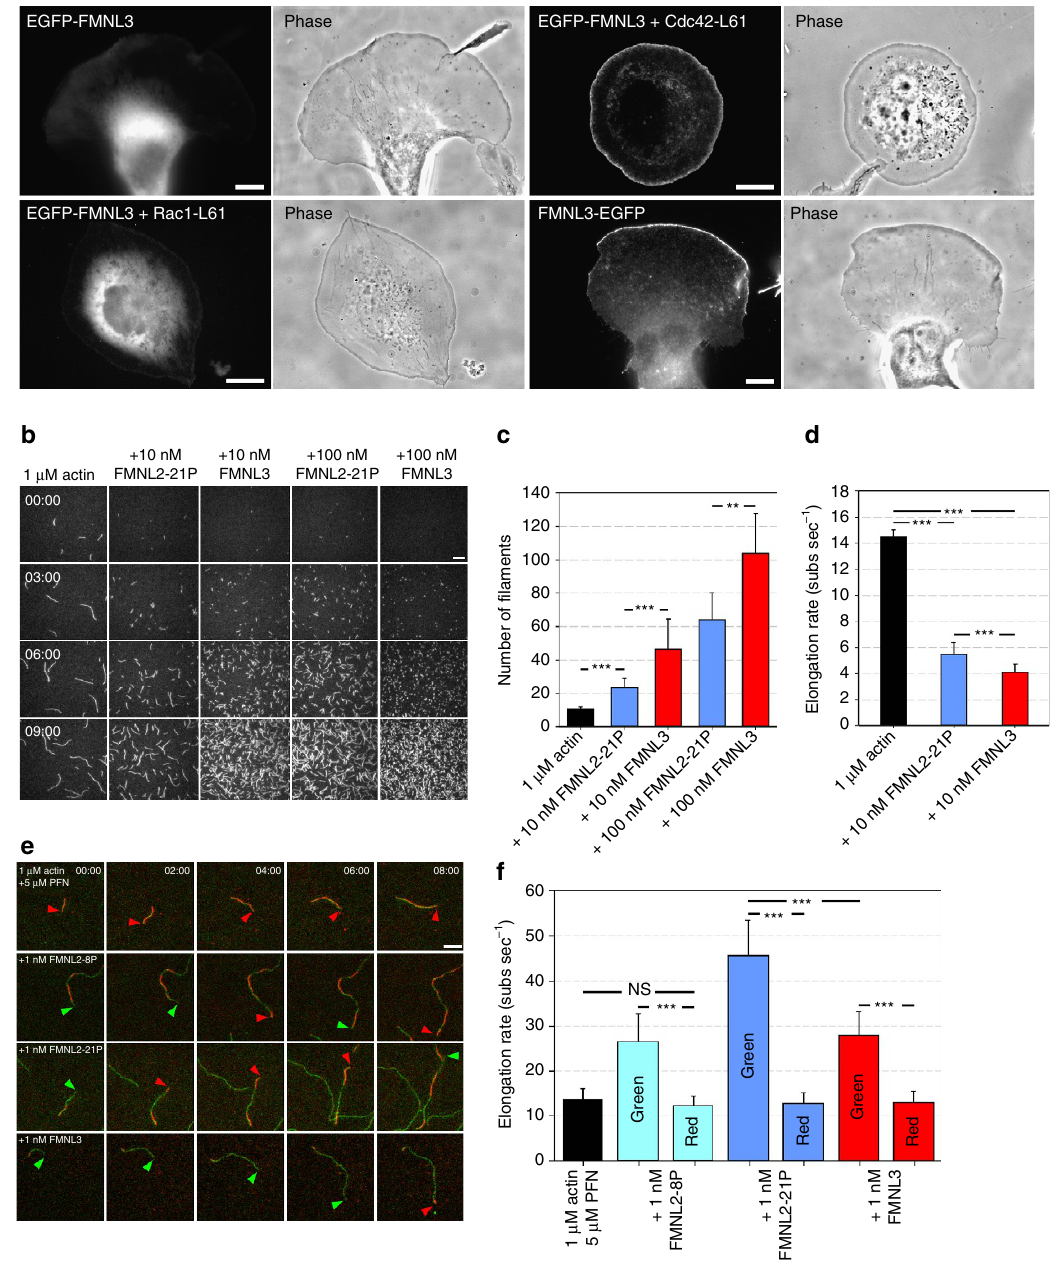
Figure 1 | FMNL3 is regulated like FMNL2, but displays diverging actin assembly properties. ( a ) Fluorescence and phase-contrast images of B16 cells expressing EGFP-FMNL3, FMNL3-EGFP or EGFP-FMNL3 co-transfected with constitutively active Cdc42 (Cdc42-L61) or Rac1 (Rac1-L61), as indicated. As shown previously with FMNL2 (ref. 29), EGFP-FMNL3, which lacks N-terminal myristoylation, is activated to target to lamellipodia by active Cdc42 but not Rac1, whereas C-terminally tagged FMNL3 is fully regulated in the absence of additional signals. Scale bars, 10 m m. ( b ) Time-lapse micrographs of TIRF microscopy (TIRF-M) assays for determination of nucleation activities. Polymerization of 1 m M G-actin (10% labelled with ATTO488, 5% labelled with ATTO565) in the absence and presence of FMNL2-21P or FMNL3 at concentrations as indicated. Only red channels are displayed in greyscale, time is in minutes; bar, 10 m m. ( c ) Nucleation activities of FMNL2-21P and FMNL3 in the absence of profilin. Filament numbers from TIRF-M images shown in b were counted 3min after addition of monomeric actin (G-actin). Error bars represent s.d. ( d ) Average elongation rates of actin filaments in the presence of FMNL2-21P or FMNL3 at 10nM compared to control filaments. Both formins significantly suppressed filament growth in the absence of profilin. Error bars represent s.d. ( e ) Time-lapse micrographs of TIRF-M assays, used for analysis of both elongation and processivity (Supplementary Fig. 4d) for each formin fragment. Polymerization of 1 m M G-actin (10% labelled with ATTO488, 5% labelled with ATTO565) with 5 m M profilin in absence and presence of 1nM FMNL2-8P, FMNL2-21P or FMNL3. Green arrowheads mark formin-elongated and red arrowheads freely growing filaments. Time, min; bar, 10 m m. ( f ) Quantification of actin filament elongation rates at low formin concentrations (1nM), allowing distinction between fast, formin-mediated growth and slow, formin-independent growth. Note that FMNL2-21P elongated filaments significantly faster than FMNL3. FMNL2-8P-mediated elongation was slower than that driven by FMNL2-21P, as expected 29 , but comparable to FMNL3. ** p o 0.01; *** p o 0.001 by Mann–Whitney rank sum test.